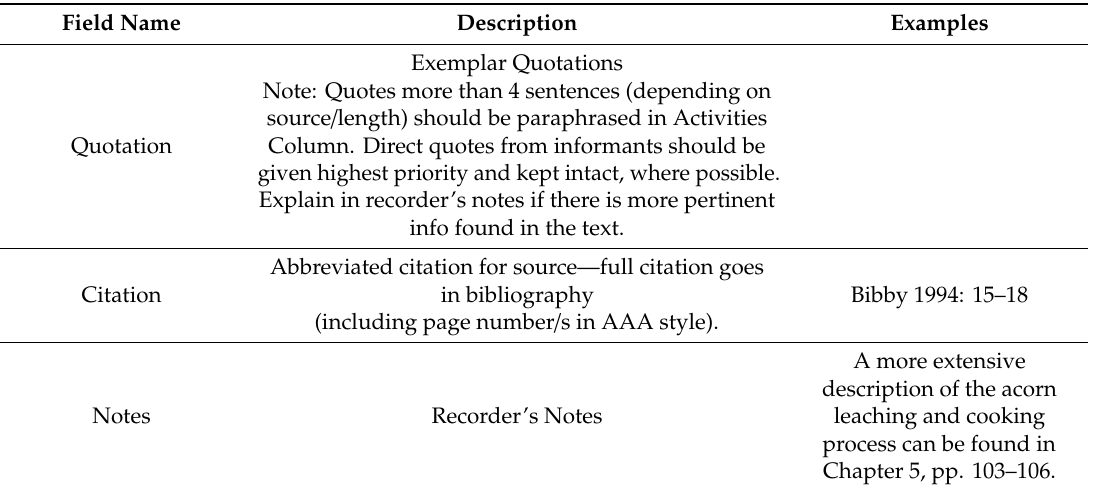
Table 2. Summary of Resource Types